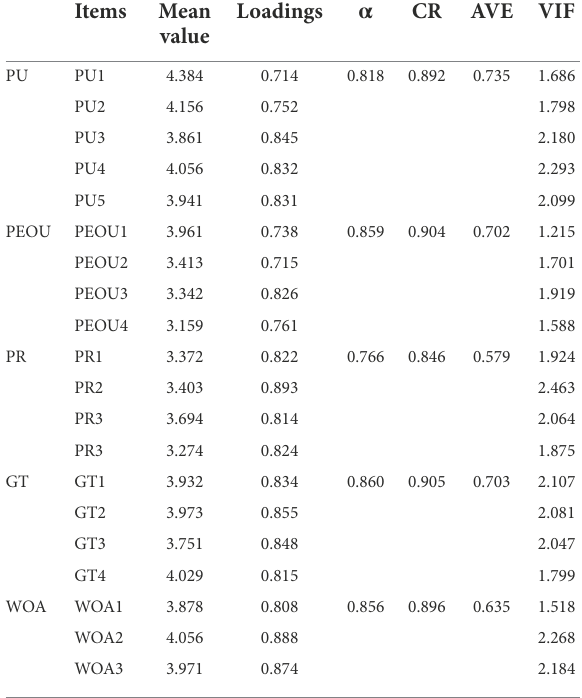
TABLE 3 Measurement model results.